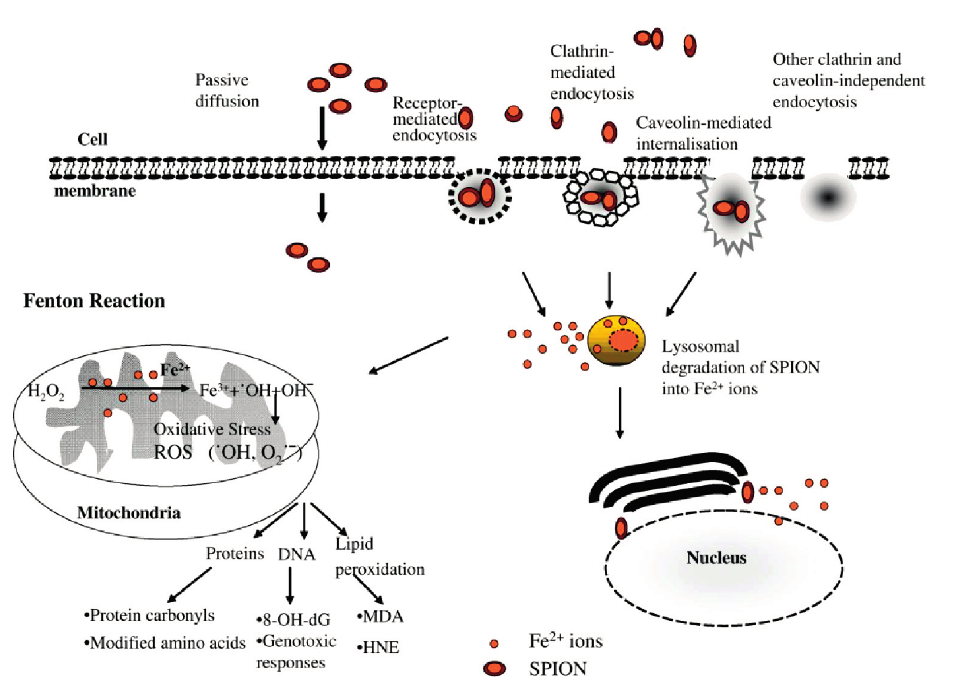
Figure 6. Schematic representation of the different intracellular uptake pathways of SPIONPs (superparamagnetic iron oxide nanoparticles) (8-OH-dG, 8-hydroxydeoxyguanosine; MDA, malondialdehyde; HNE, 4-hydroxy-2-nonenal). Reprinted from [195] with permission from Singh et al. [195], Copyright